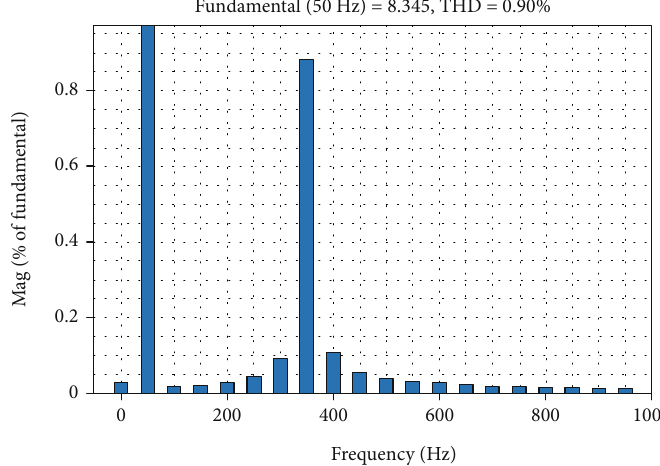
Figure 35: THD values for PV system current.